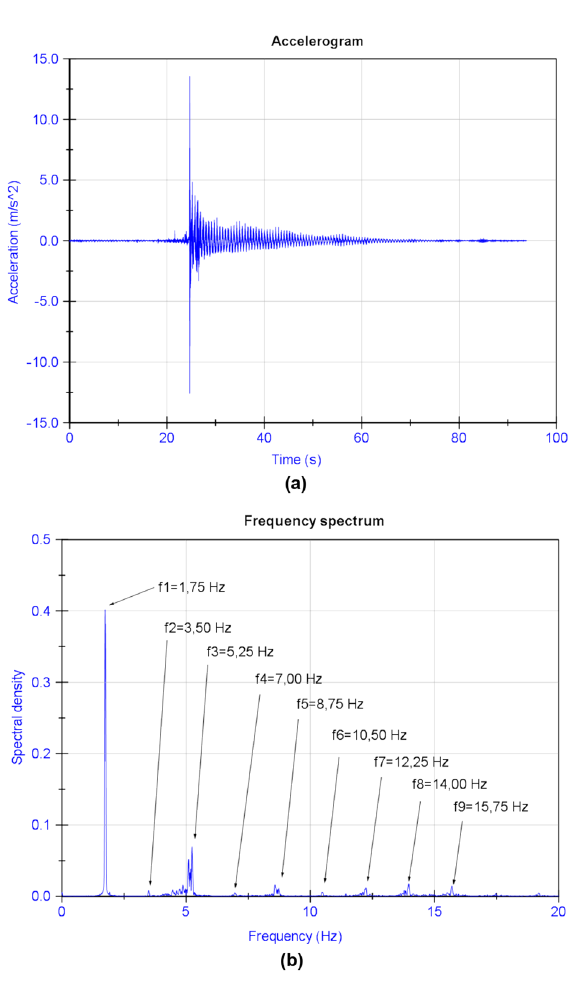
Figure 11. Obtaining the stresses in the fifth stay cable family from their vibration frequencies: ( a ) accelerogram; ( b ) frequency